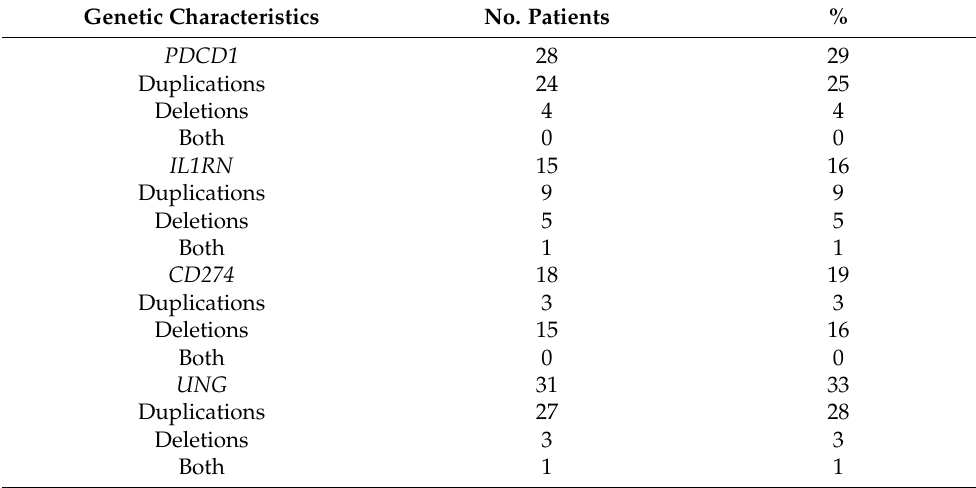
Table 2. Cont. Genetic Characteristics No.